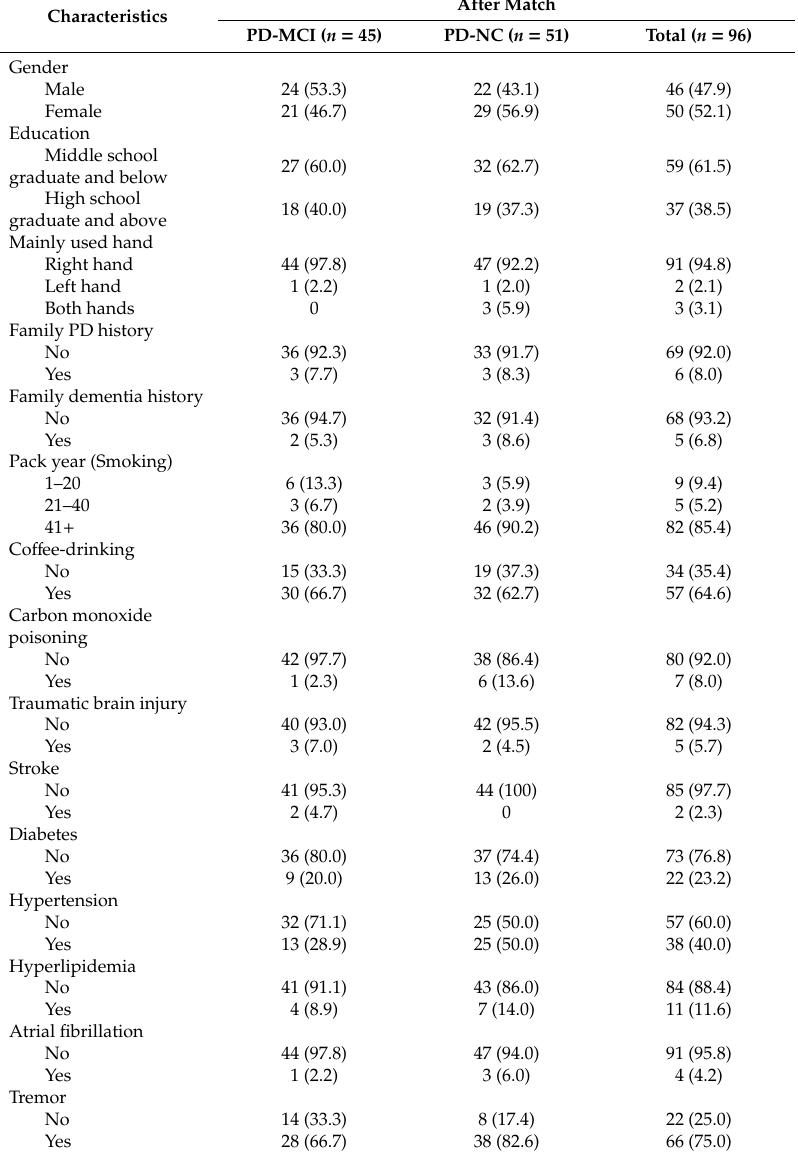
Table 2. General characteristics of the subjects, n